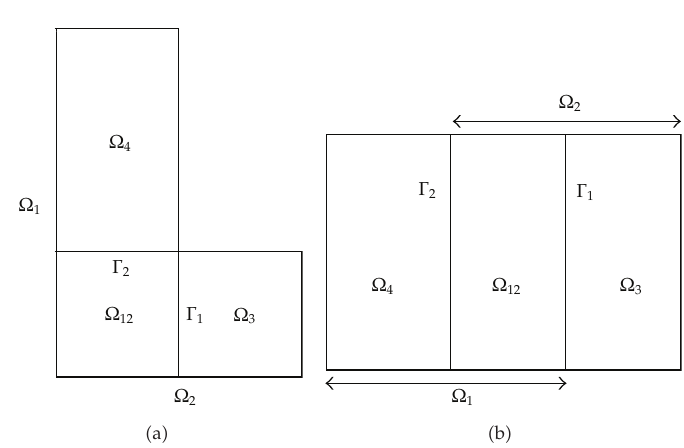
Figure 1: Two examples of domain decompositions (cid:2) Schur and Schwarz (cid:3)